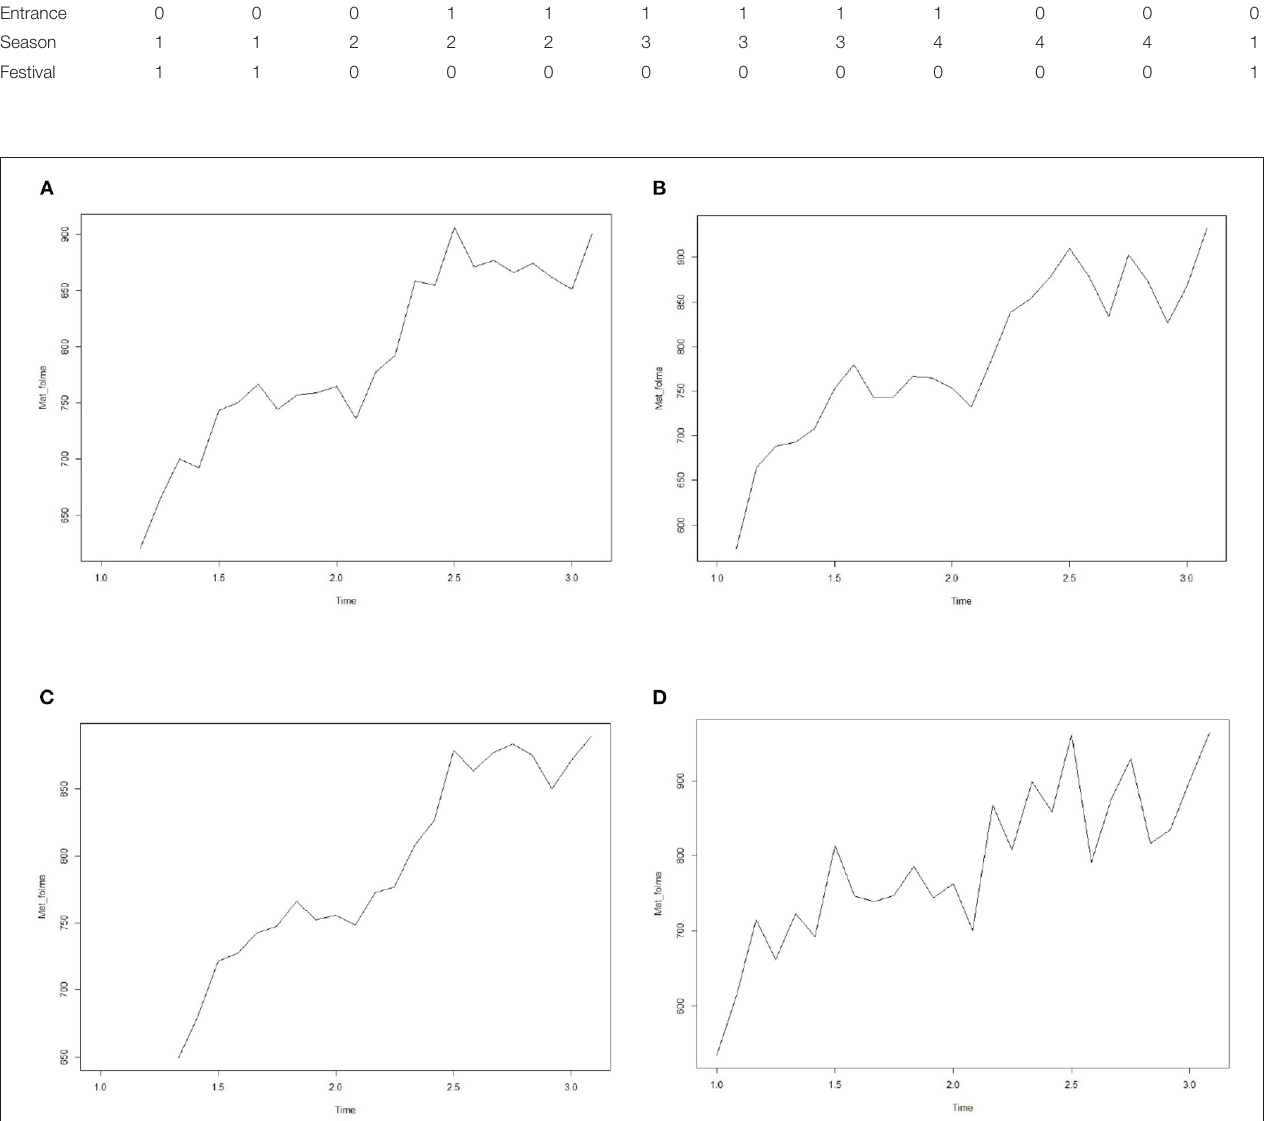
FIGURE 3 | Smooth time series diagram of patient flow. Figures (A–D) represent corresponding smoothing curves of order 1, 2, 3 and 5 respectively.